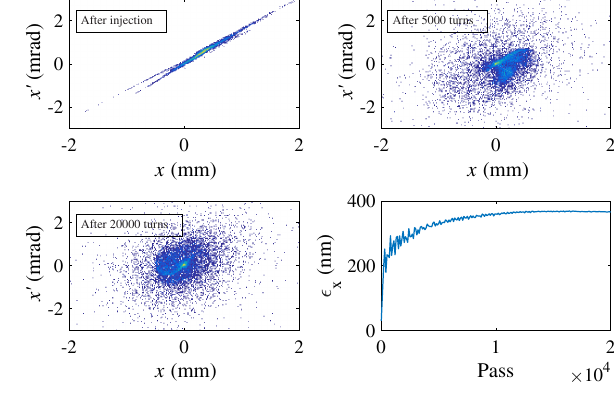
FIG. 13. Emittance increase after injection.